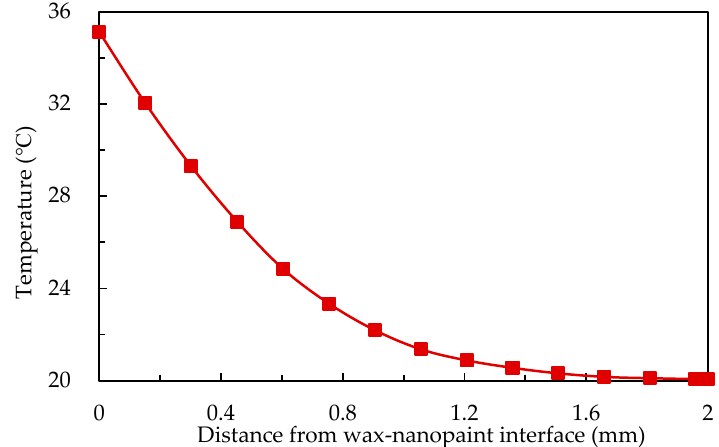
Figure 3. Radial temperature distribution of the wax layer after heating (original wax layer temperature is 20 °C; magnetic field frequency is 500 kHz; electrical current intensity is 20 A; SPM-NP diameter